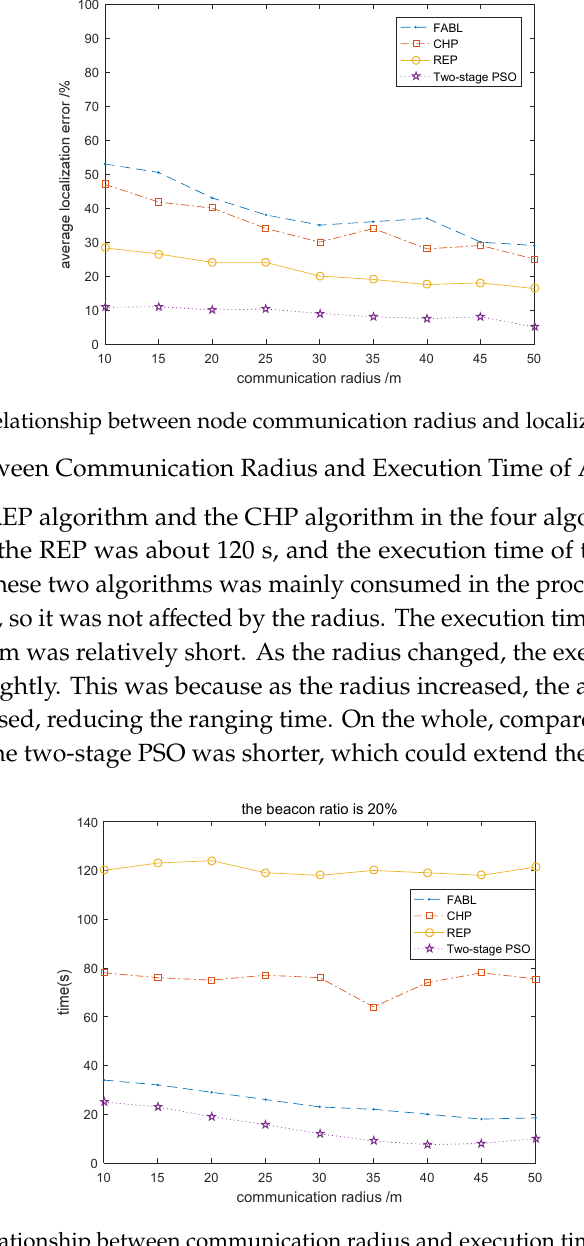
Figure 10. Relationship between communication radius and execution time of algorithm.